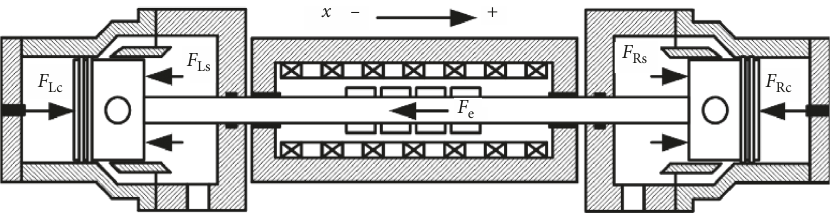
Figure 3: The prototype dynamics model.